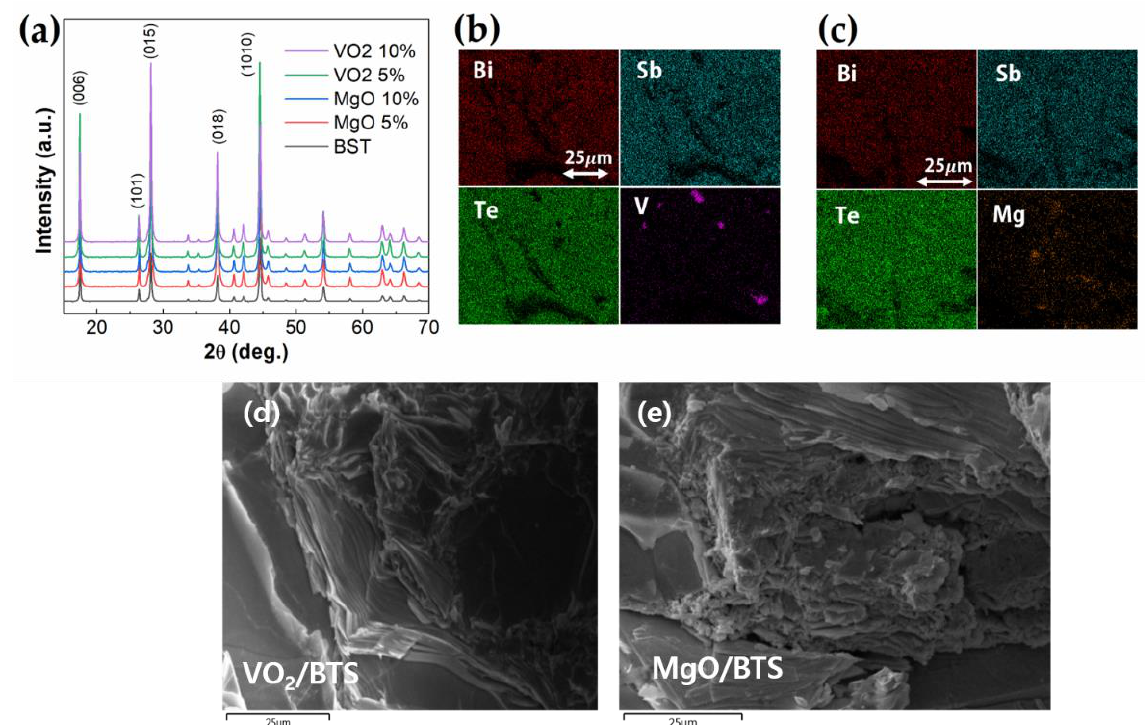
Figure 1. ( a ) X-ray diffraction patterns of MgO/VO 2 BST composites; ( b , c ) are the elemental mapping images by energy dispersive X-ray spectroscopy (EDX) of the VO 2 and MgO composite; ( d , e ) are the scanning electron microscope (SEM) images of the VO 2 and MgO composite.